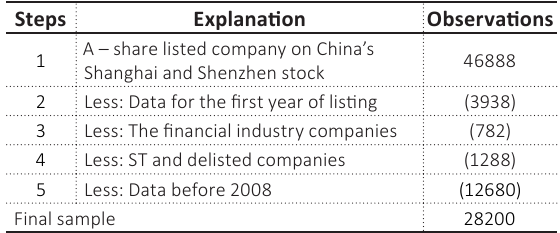
Table 1. Sample selection process